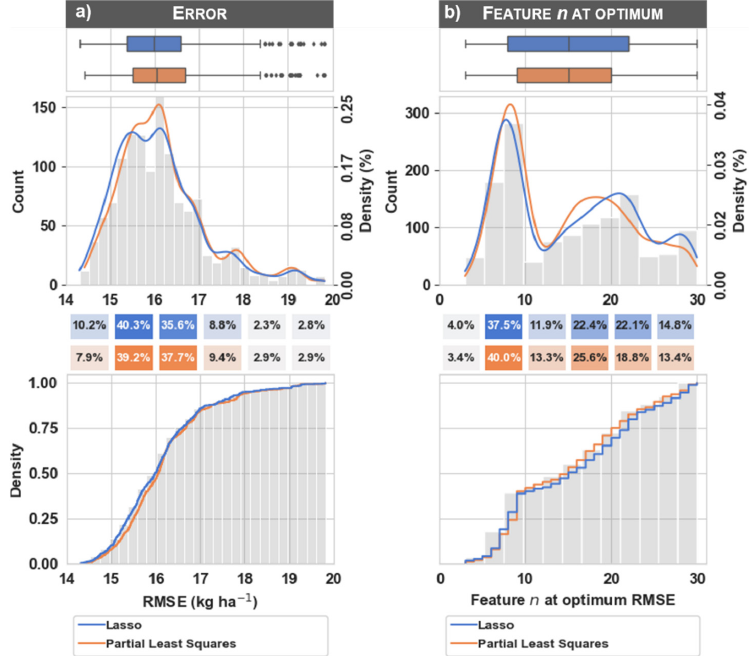
Figure A2. Box plots, density estimates, and empirical cumulative density functions (ECDF) of ( a ) cross-validated root mean squared error (RMSE) values and ( b ) number of features at optimum RMSE for the two supervised regression estimators used for this experiment (blue refers to error